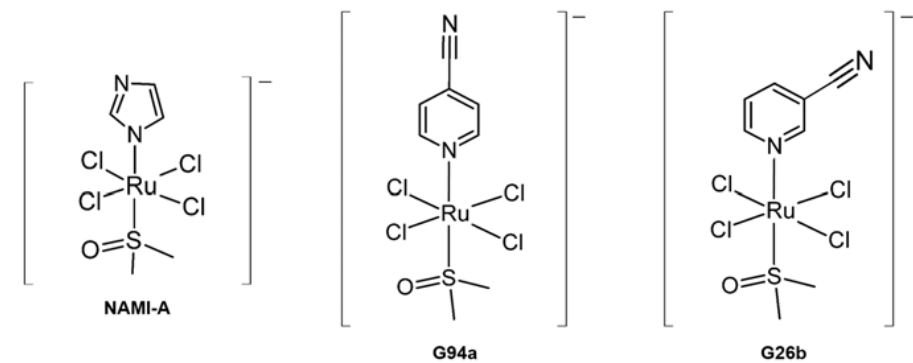
Figure 6. Ru(III) complexes regulating the activity and expression of MMPs.